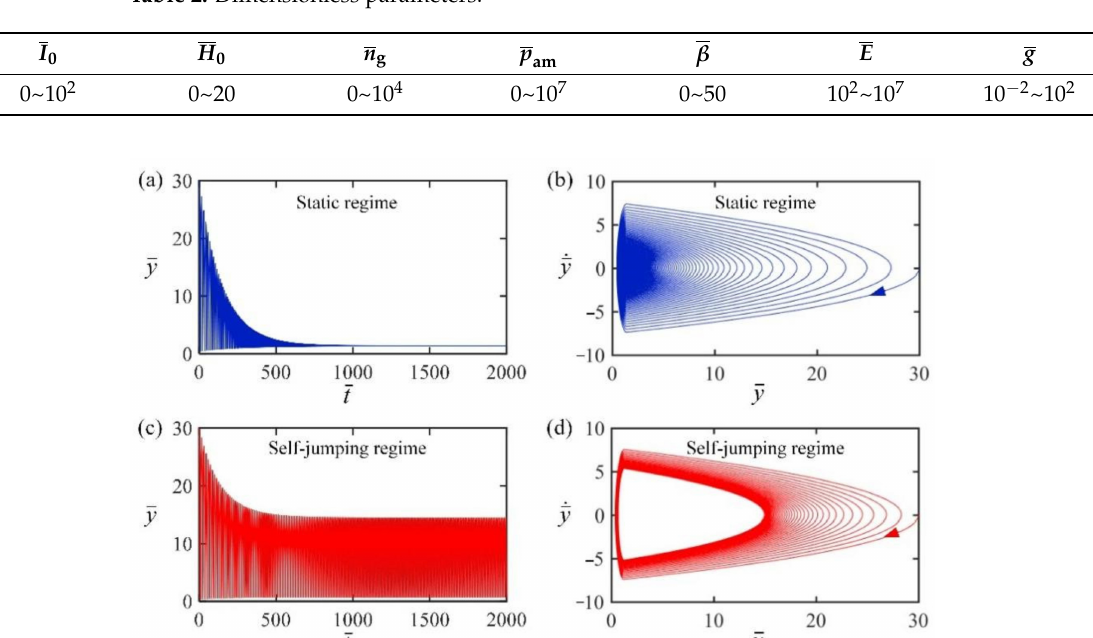
Figure 2. Time histories and phase trajectories for two motion regimes of the LCE balloon. ( a , b ) The static regime with I 0 = 0; ( c , d ) the self-jumping regime with I 0 = 2. The other parameters are C 0 = 0.3, H = 4, β = 0.01, E = 500, n g = 200, p balloon under steady illumination, there exist two typical motion regimes: the static regime and the self-jumping